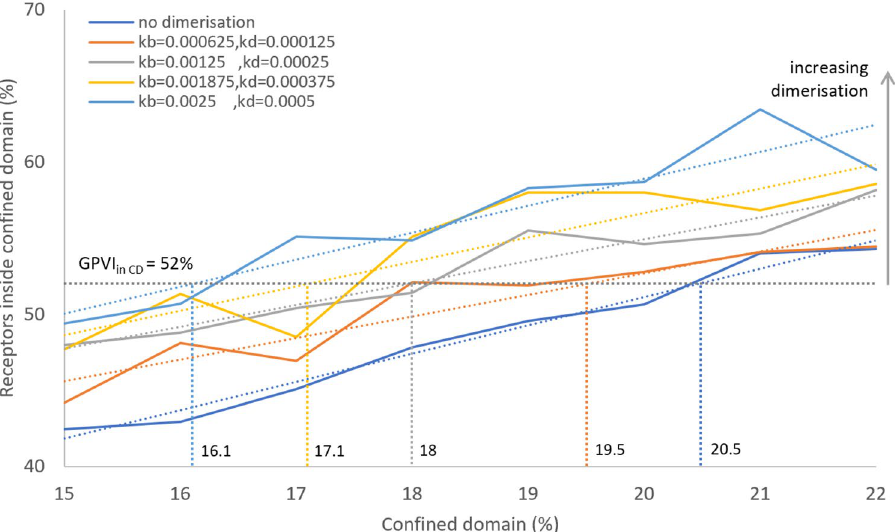
Figure 10. Enforced GPVI dimerisation reduces the confined domain area for a given GPVI localisation ratio. Plot of simulation of GPVI localisation in the presence of a confined domain with variable occupied area. Note the near linear increase of receptors inside the confined domain when this area increases. The reported value of GPVI with restricted movements 40 is about 50%, pointing to a confined domain size of 20–21%. In the presence of dimerisation, this area slightly decreases to 19–20%, with a k b = 0.000625 and k d = 0.000125 (least square regression analysis).